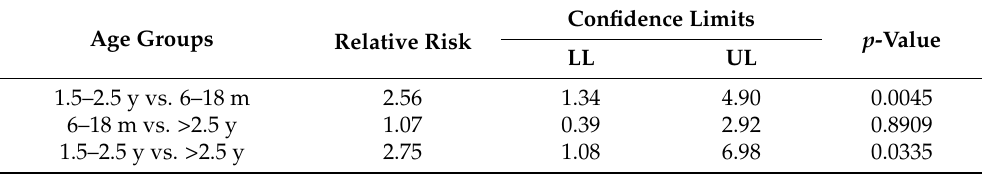
Table 8. The relative risk of brucellosis in different age groups of wild